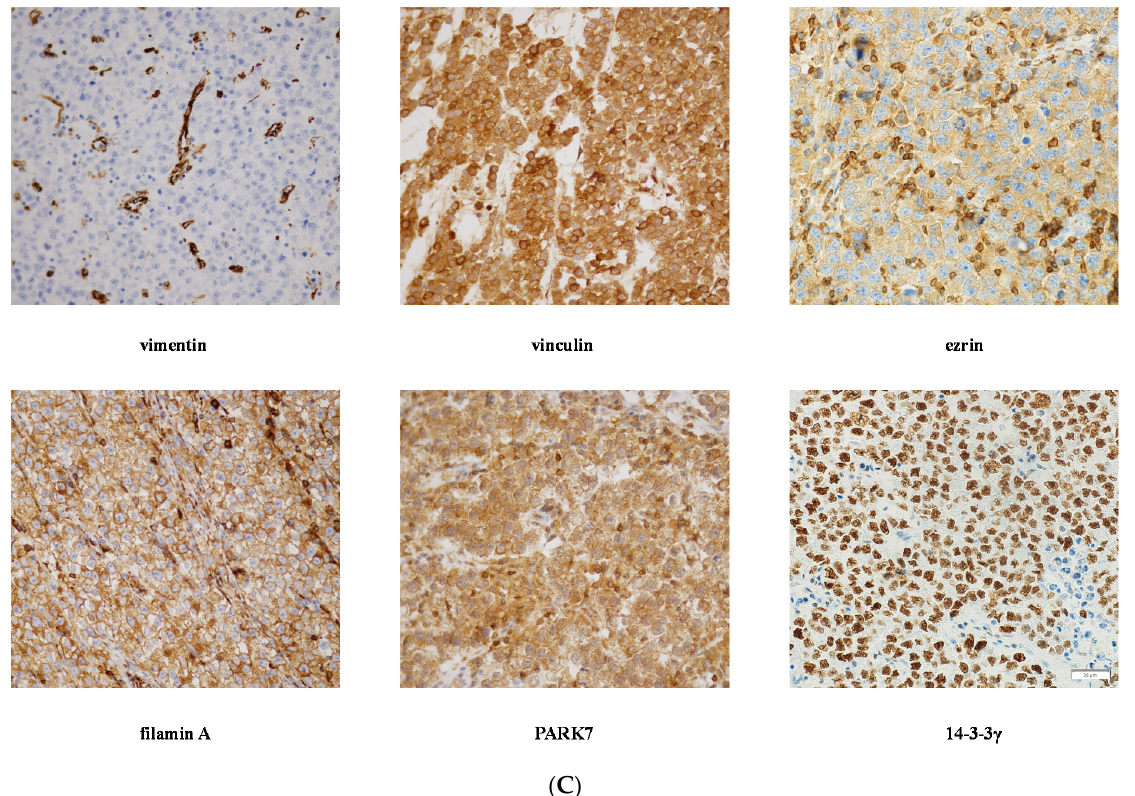
Figure 2. IHC of expression of 14-3-3 γ , ezrin, filamin A, PARK7, vimentin and vinculin in CS I seminoma patients. Filamin A staining in seminoma (S), IGCN and benign tubules (T). Original magnification 10×. Insert: detail of filamin A positivity in IGCN, original magnification 60× ( A ). Representative photomicrographs of IHC staining of 14-3-3 γ , ezrin, filamin A, PARK7, vimentin and vinculin in RTI-positive ( B ) and -negative ( C ) CS I seminoma patients. Original magnification 40×. Scale bar shown for 14-3-3 γ applies to all proteins examined.